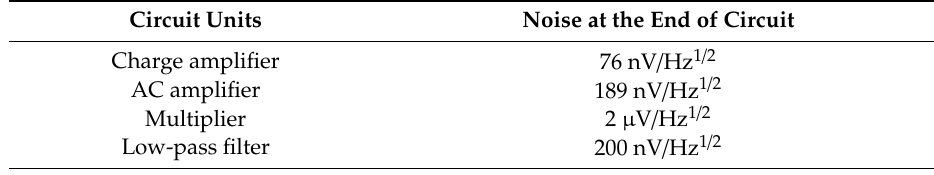
Table 2. Table 2. The noise of each part, converted to the end of the capacitive transducer by theoretical theoretical calculation. calculation.